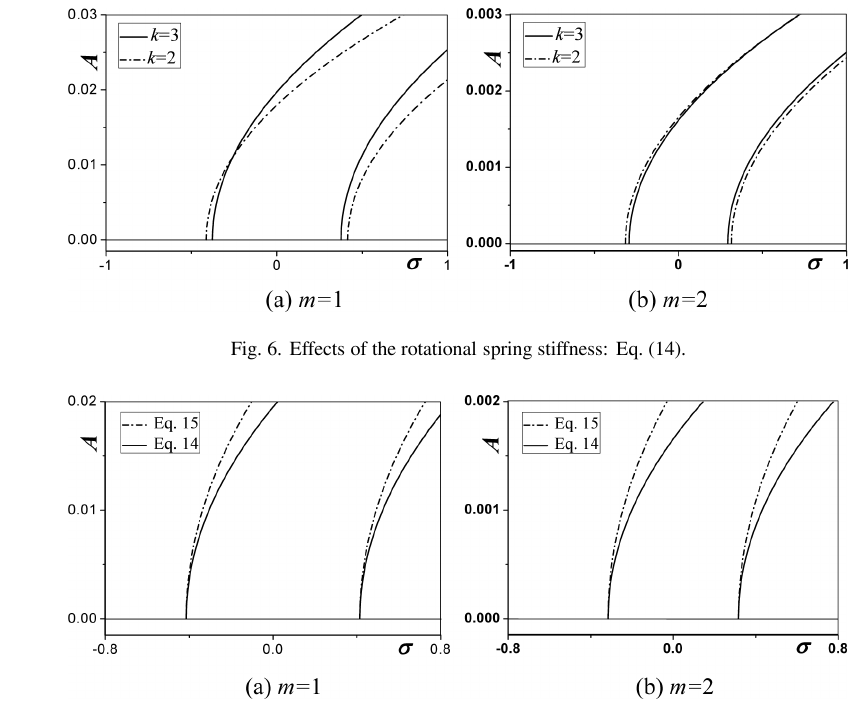
Fig. 7. Comparison of results from Eqs (14) and